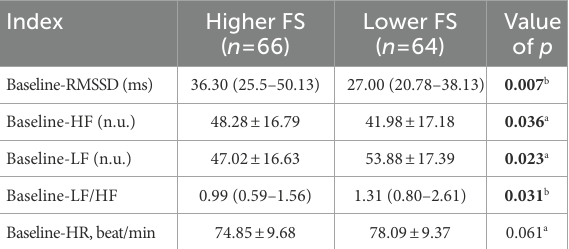
TABLE 3 Between-group comparisons at baseline HRV in higher FS group and lower FS group.